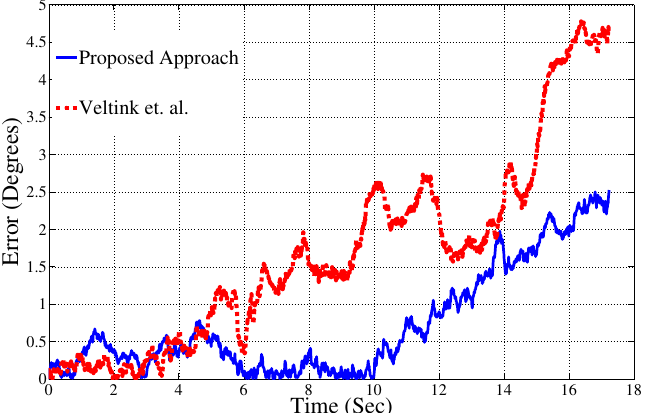
Figure 11. Proposed algorithm outperforms Kalman filter approach during high acceleration.